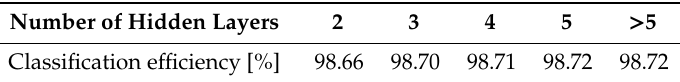
Table 1. Results of the classification efficiency.